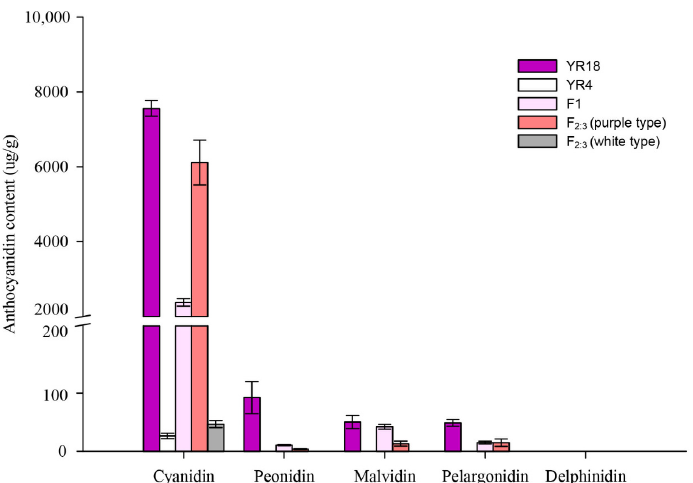
Figure 3. Anthocyanidin compositions and contents of the flower petals in diverse genotypes. In- bred lines ‘YR18’ and ‘YR4’ were the parental lines used for constructing the mapping population. The F 1 lines were derived from a cross between the parental lines. Both F 2:3 (purple type) and F 2:3 (white type) refer to bulk pools, which were collected according to the flower colors in the F 2:3 pop- ulation. The horizontal and vertical axes respectively present the main anthocyanidin compounds (e.g., cyanidin, peonidin, malvidin, pelargonidin, and delphinidin) and the anthocyanidin contents (µg/g). Three biological replicates were